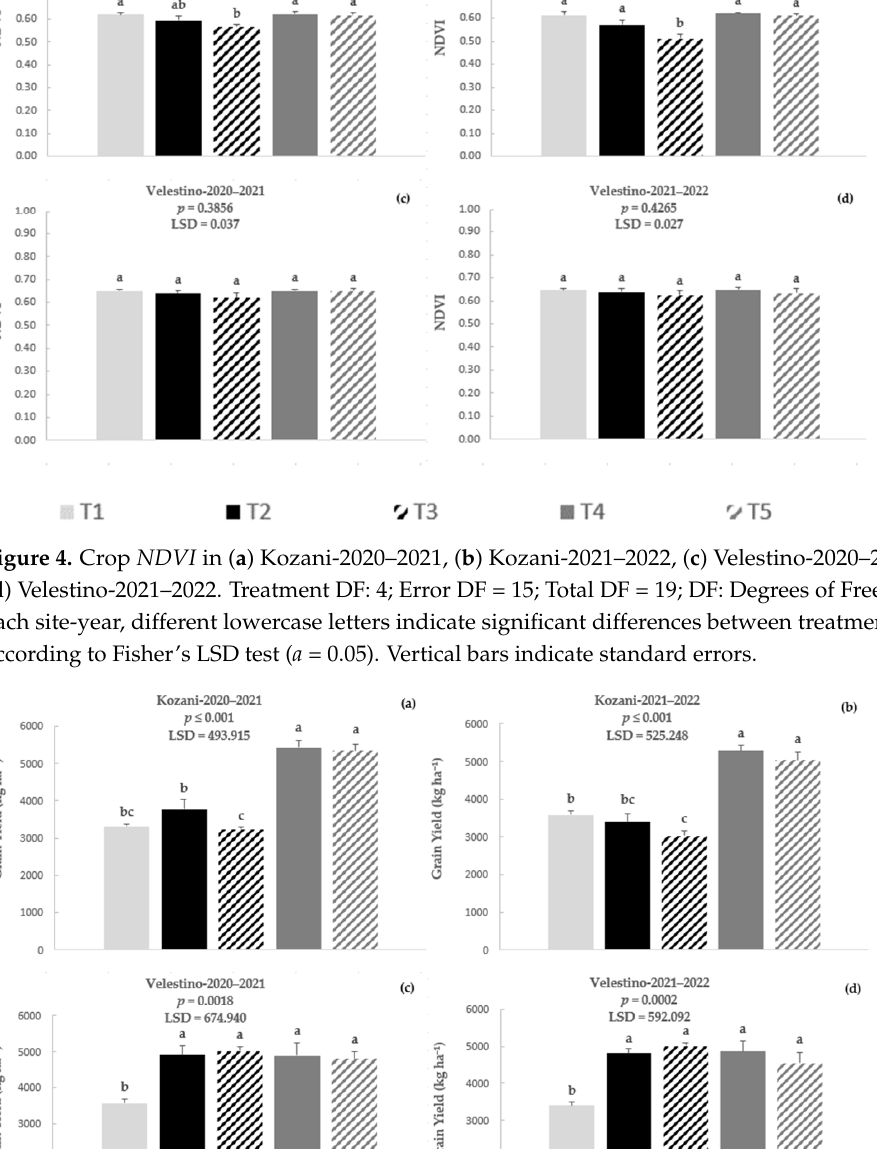
Figure 6. Linear regression between grain yield ( y ; kg ha − 1 ) and crop NDVI ( x ) in ( a ) Kozani ‐ 2020– 2021 (intercept SE: 4220.57; slope SE: 6973.19), ( b ) Kozani ‐ 2021–2022 (intercept SE: 2104.22; slope SE: 3582.82), ( c ) Velestino ‐ 2020–2021 (intercept SE: 3984.09; slope SE: 6196.51), and ( d ) Velestino ‐ 2021– 2022 (intercept SE: 5749.82; slope SE: 9008,99). Model DF: 1; Residual DF: 18; Total DF: 19; DF: Degrees of Freedom; SE: Standard Error; RMSE: Root Mean Square Error; MAE: Mean Absolute Error; R 2 : Coefficient of Determination (adjusted for DF).